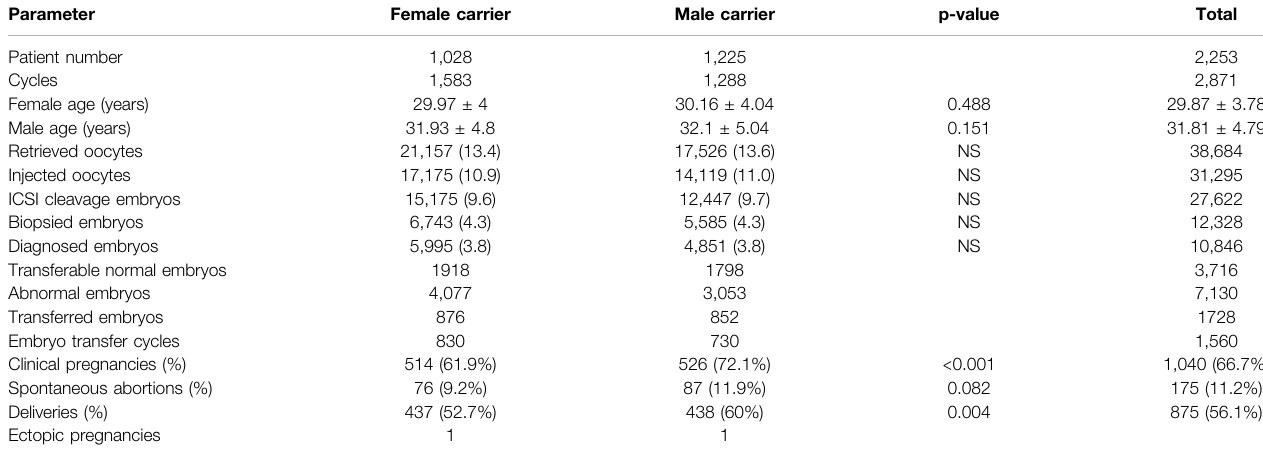
TABLE 1 | Clinical characteristics and preimplantation genetic testing for chromosomal structural rearrangement outcomes of reciprocal translocation heterozygotes. Parameter